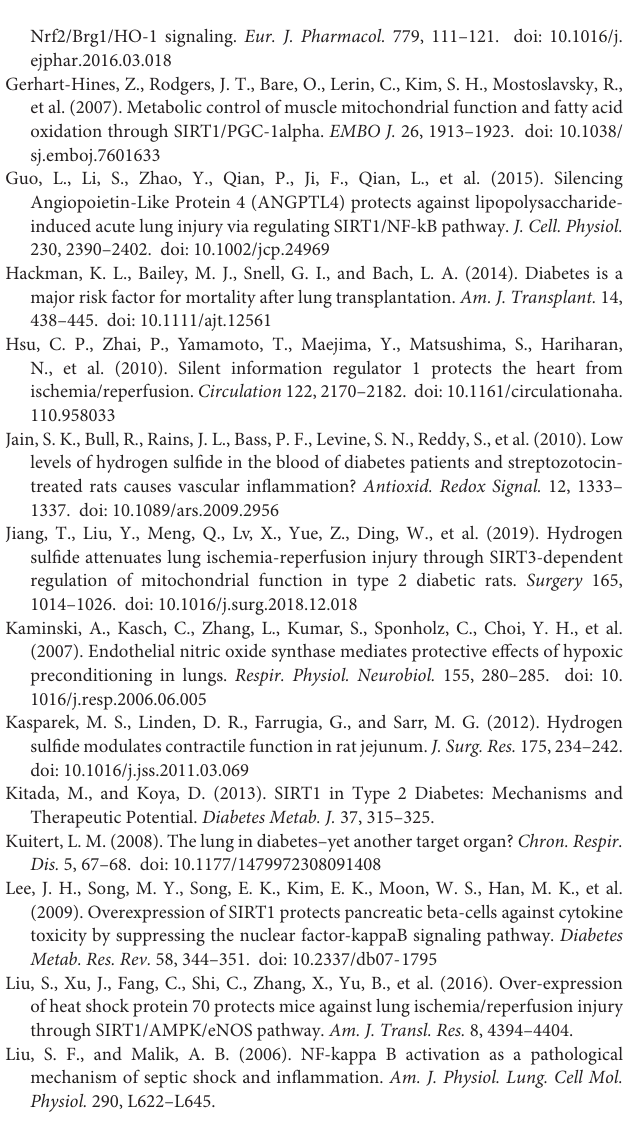
FIGURE S1 | The effect of EX527 on diabetic lung. (A) Arterial blood gas analysis. T0-T7 represent the following time points: baseline, end of ischemia, and 30 min, 60 min, 90 min, 120 min, 180 min, and 240 min after reperfusion. (B) Static compliance of the lung pressure–volume (P–V) curves. Data are represented by the mean values, and the bars are omitted for clarity. (C) Histologic analysis of lung tissues. (magnification: 200 × ). (D) Lung injury score. (E) Wet/dry weight ratio. (F) Representative blots. (G) Cleaved caspase-3 expression (n = 8 in each